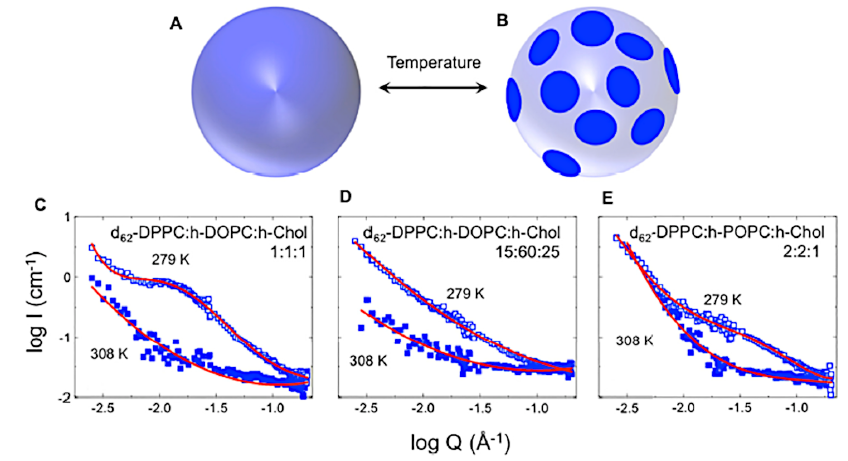
Figure 7. Temperature-dependent domain formation in multicomponent phospholipid